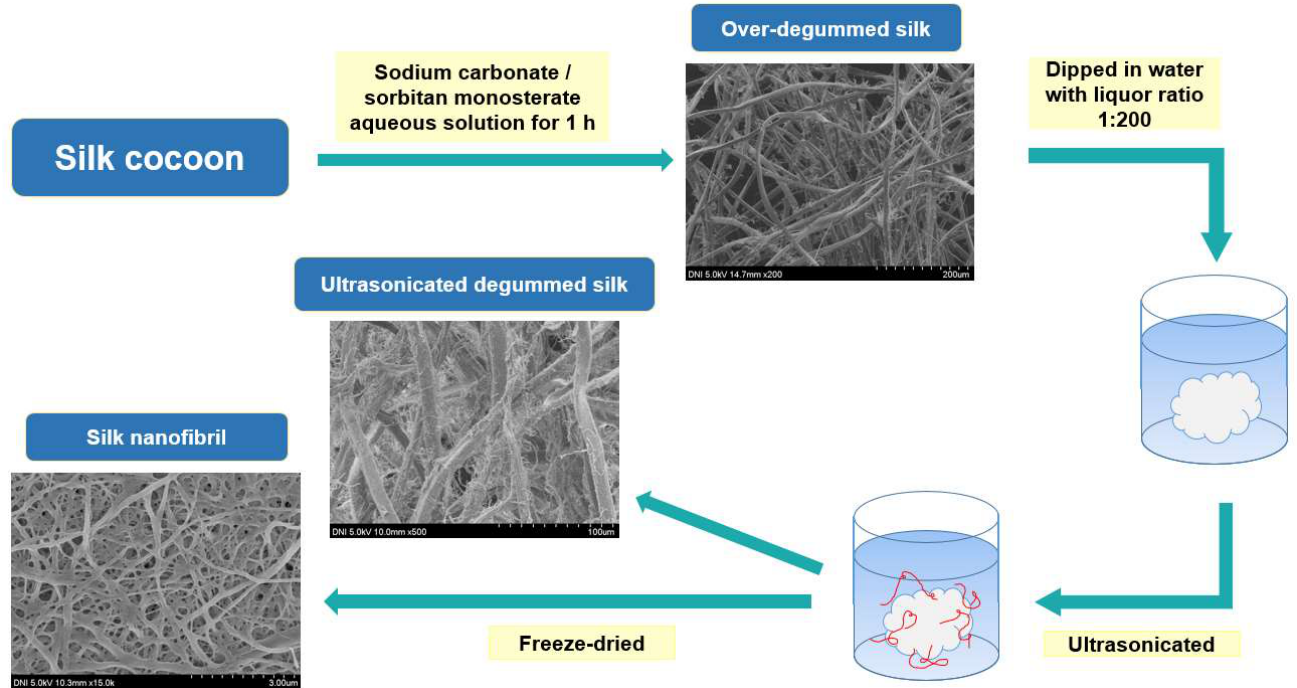
Figure 7. Schematic representation of the fabrication of silk nanofibrils.